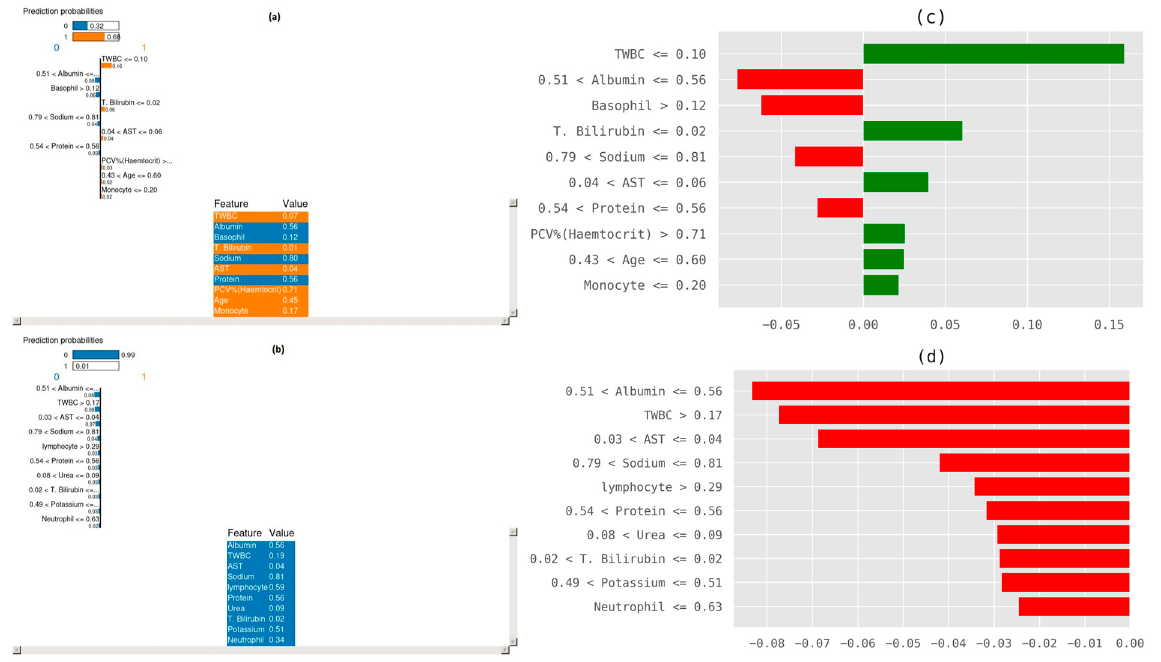
Figure 11. LIME interpretation for model output. ( a ) Positive COVID-19 prediction ( b ) Negative COVID-19 prediction ( c ) Positive COVID-19 prediction ( d ) Negative COVID-19 prediction.